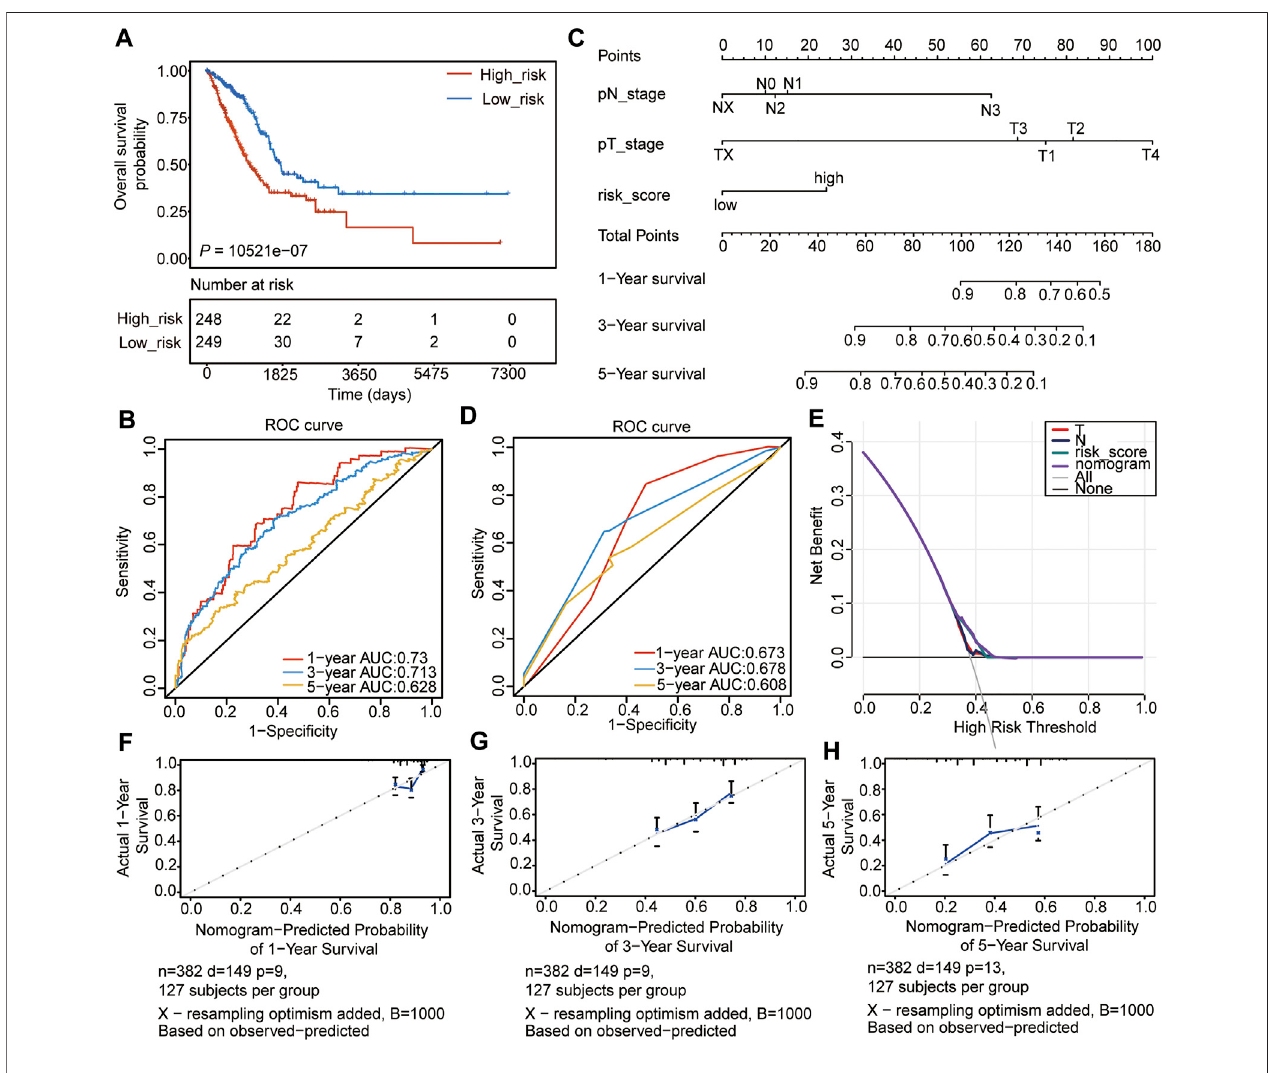
FIGURE 4 | Internal validation of the prognostic signature. (A) OS of high- and low-risk groups. (B) ROC analyses of the model for 1-, 3-, and 5-years. (C) Nomogram to predict the prognosis of patients with LUAD. (D) ROC analyses of the nomogram model for 1-, 3-, and 5-years. (E) DCA result of the nomogram model. (F – H) The calibration analysis of the nomogram predicted the probability of 1-year survival (F) , 3-years survival (G) , and 1-year survival (H) .